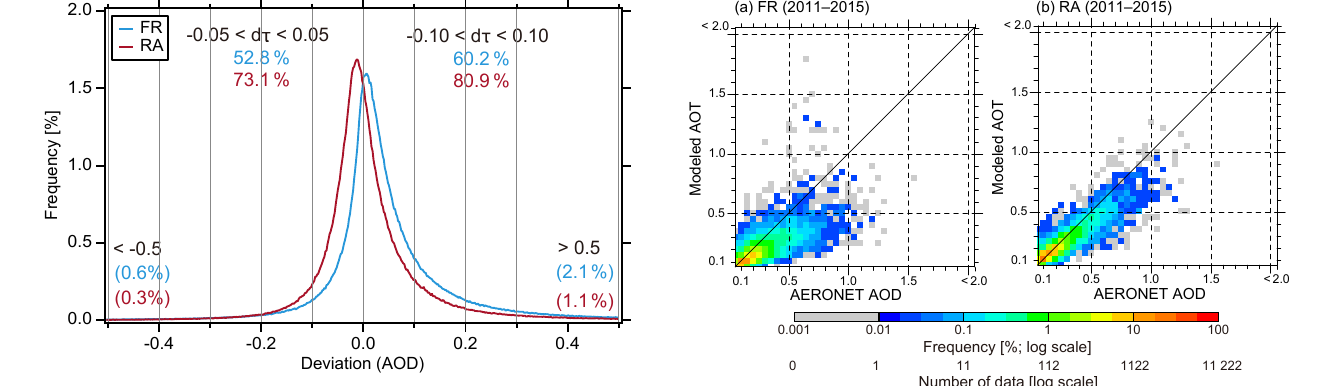
Figure 14. Scatter plots of (a) FR AODs and (b) RA AODs ver- sus monthly averaged AERONET AODs for the whole reanalysis period